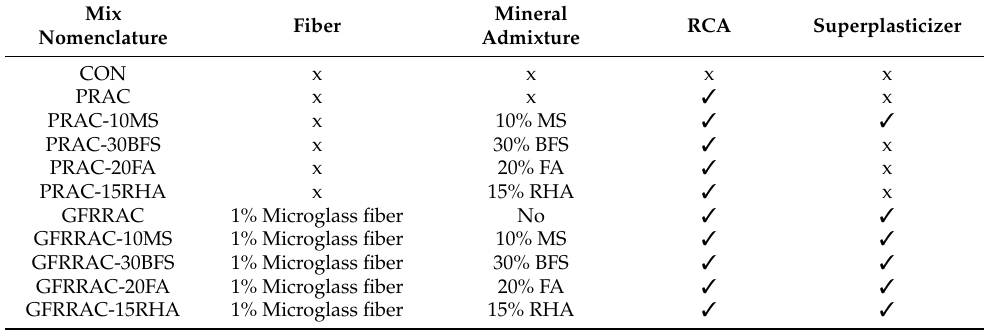
Table 3. Nomenclature of mixes.